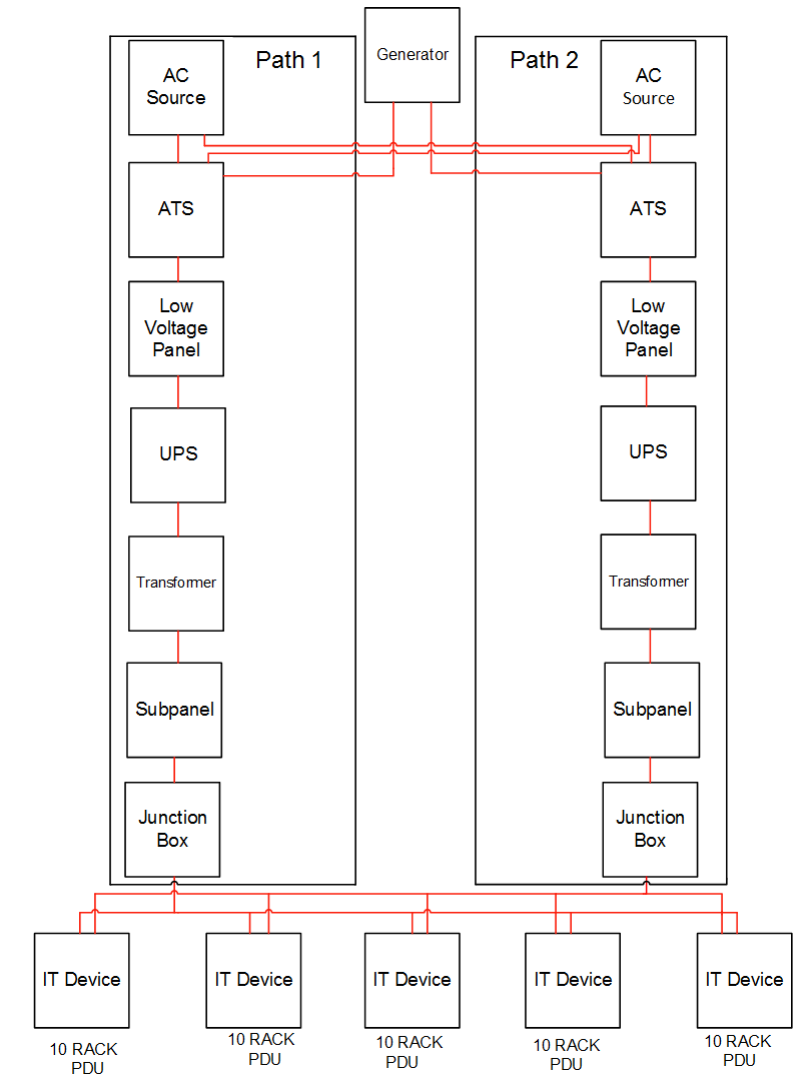
Figure 19. Data center power infrastructure.